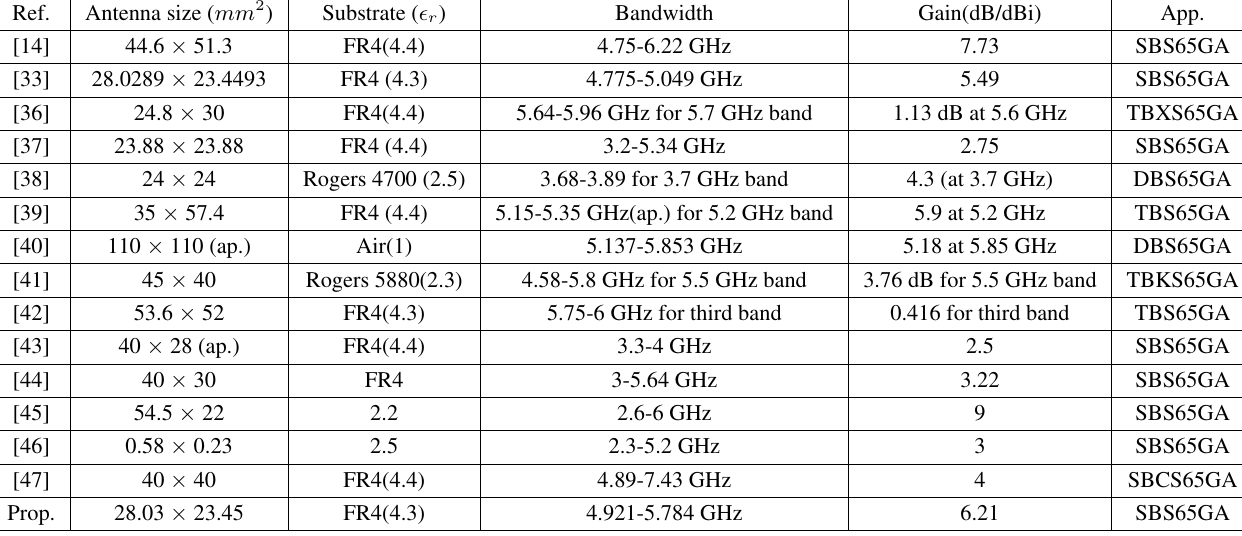
TABLE 4. Comparison of the proposed HGWMPA with existing antennas